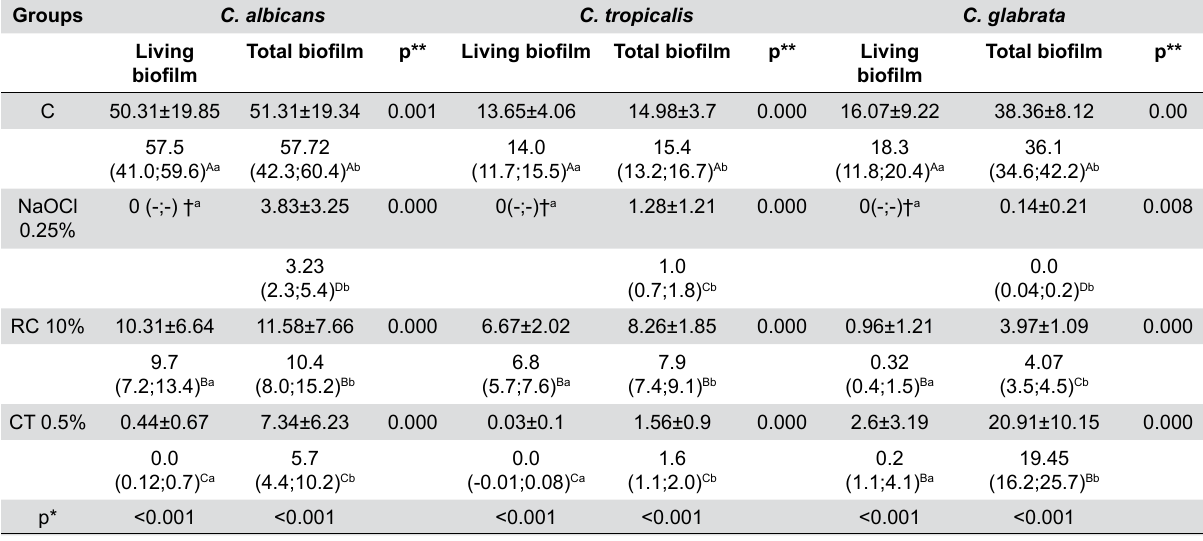
Table 1- Comparison (mean and SD, Median and CI) of the living biofilm area and total biofilm area, in percentage, after immersion of the specimens in the disinfectant and control